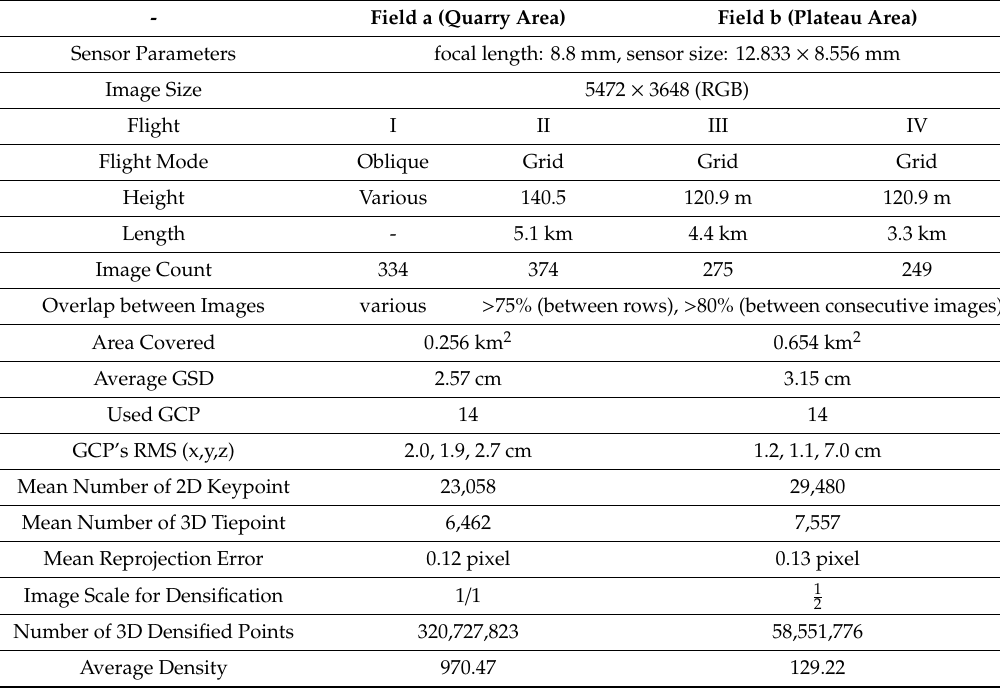
Table 3. Flight and image processing information.